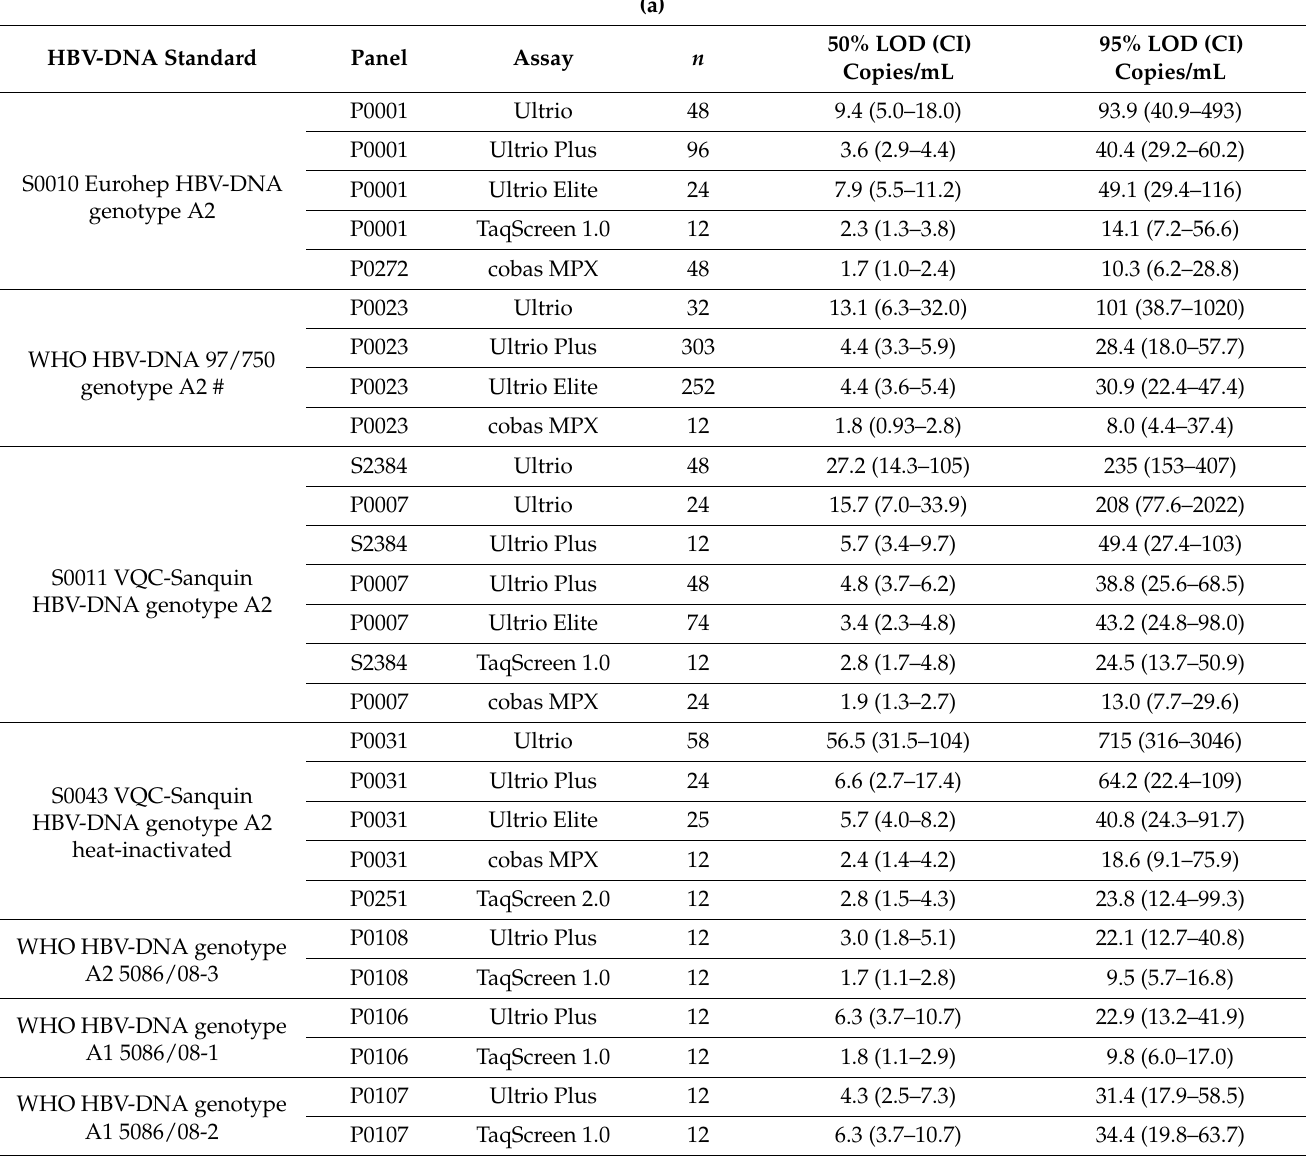
Table 4. Detection limits of different Procleix Ultrio and cobas MPX versions calculated by probit analysis on data reported by laboratories that tested the analytical sensitivity panels of different genotypes manufactured from calibrated standards in copies/mL by BioQControl. ( a ) Detection limits on HBV-DNA genotype A standard dilution panels ( b ) Detection limits on HBV-DNA genotype B and C standard dilution panels. ( c ) Detection limits on HBV-DNA genotype D and E standard dilution panels. ( d ) Detection limits on HBV-DNA genotype F and G